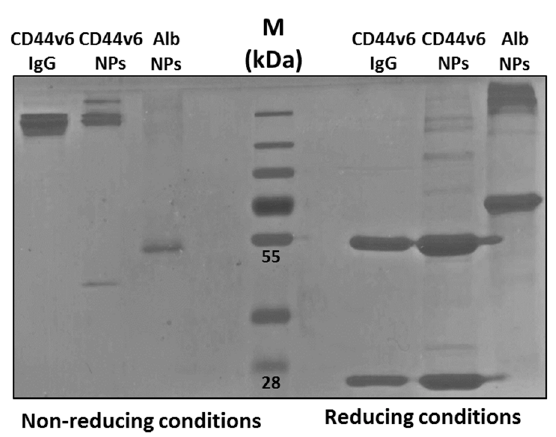
Figure 6. Analysis by SDS-PAGE of antibody anti-CD44v6 (ab-CD44v6) conjugation to NPs. An equal amount of NPs were treated in reducing (heat and β -mercaptoethanol) and non-reducing conditions and loaded into a 10% polyacrylamide gel. CD44v6-IgG: free Ab-CD44v6 immunoglobulin G; CD44v6-NPs: NPs conjugated with the Ab-CD44v6; Alb-NPs: NPs conjugated with Albumin; M protein Marker.